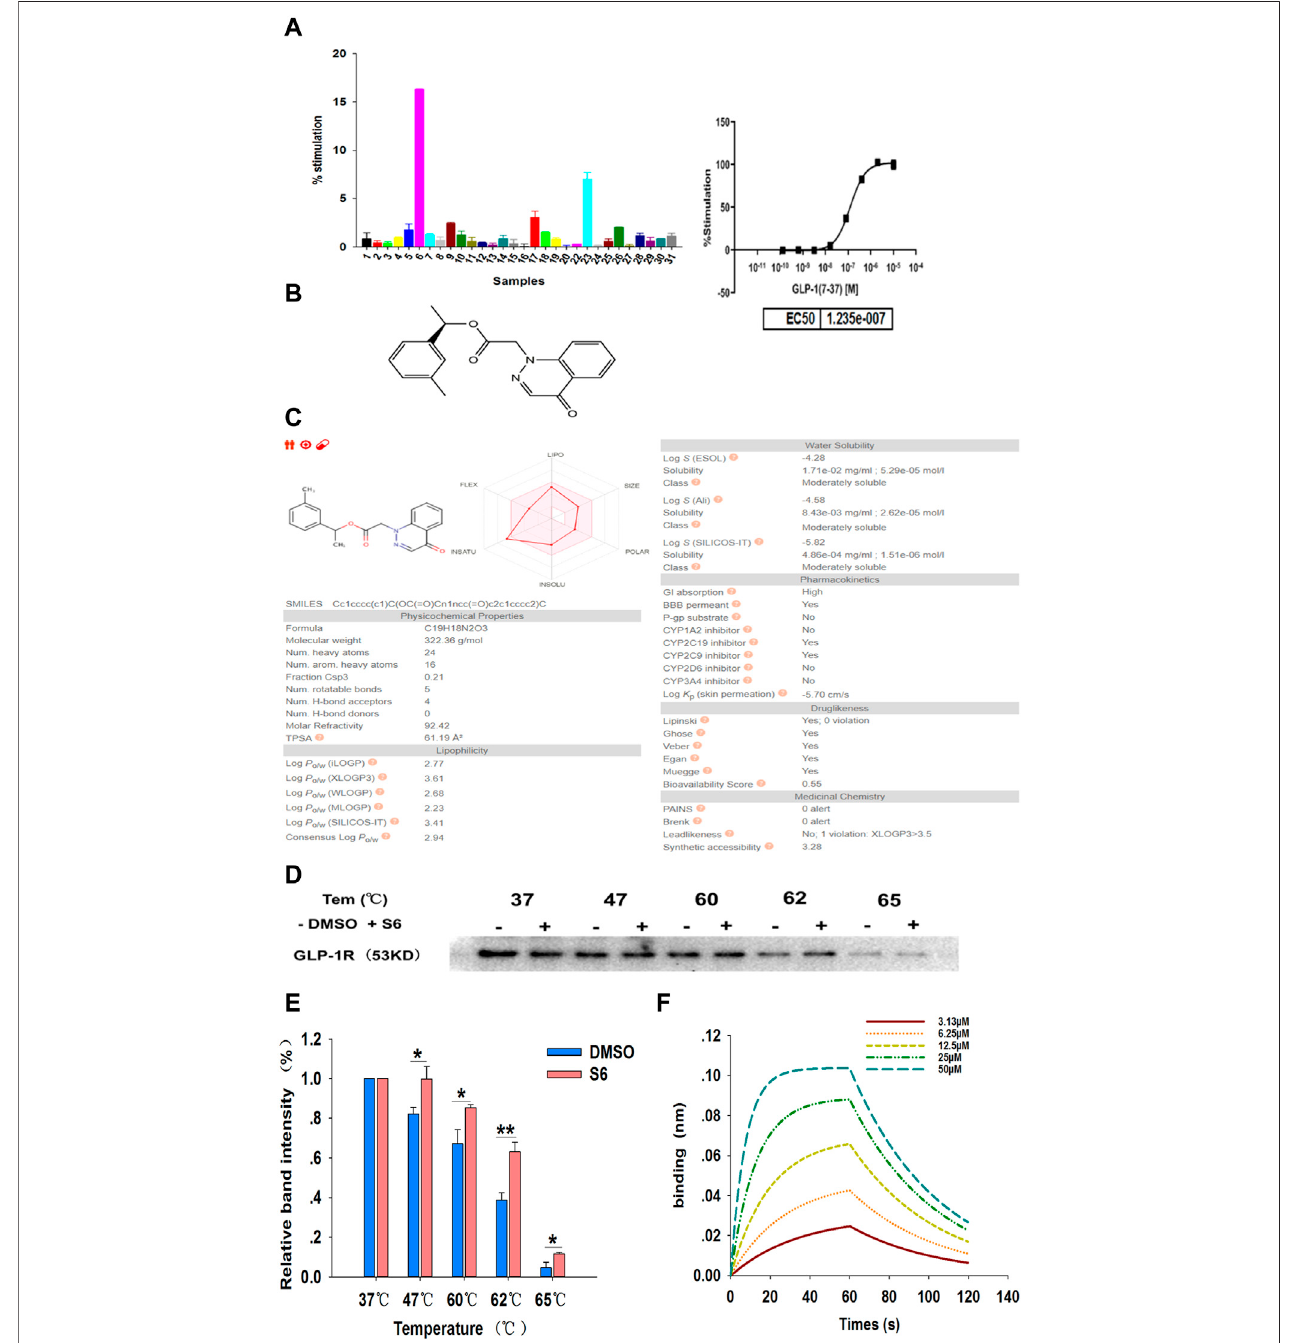
FIGURE2| Screeningand identi fi cation ofsmall molecule GLP-1Ragonist S6throughFLIPR-basedcalcium assaysand CETSA. (A) The intracellular Ca 2+ signals in CHO-K1/GLP-1R/G α 15 cells were measured using Calcium 4 Assay Kit, with GLP-1 (7-37) as a positive control (The maximum concentration was 10 μ M, 5-fold dilution, 8-point concentration). The average fl uorescence intensity value in the fi rst 20 s is considered as the baseline level, the maximum fl uorescence intensity value from 21 to 120 s minus the minimum fl uorescence intensity value from 21 to 120 s is expressed as the relative fl uorescence intensity value ( Δ RFU). The activation percentage was calculated according to the following equation: % stimulation rate (cid:2) ( Δ RFU compounds — Δ RFU background)/( Δ RFU positive control — Δ RFU background) × 100%.Dataareexpressedasthemean ± SD,n (cid:2) 3. (B) ThechemicalstructureofS6(1-(3-methylphenyl)ethyl2-(4-oxo-1,4-dihydrocinnolin-1-yl)acetate), Molecular formula C 19 H 18 N 2 O 3 ; Molecular weight is 322.364. (C) ADME pro fi ling for the compound S6 using SwissADME. (D) CETSA for cell lysate treated with DMSO and S6 (10 μ M) were conducted using western blotting to detect the interaction between S6 and GLP-1R, and quanti fi cation of this data is shown in (E) . Data are expressed as the mean ± SEM and compared by one-way ANOVA. n (cid:2) 3, * p < 0.05, ** p < 0.01. (F) Binding pro fi les of S6 to GLP-1R measured by BLI in OctetRED96. Binding kinetics was fi t to 1:1 binding model by SigmaPlot 12.5.